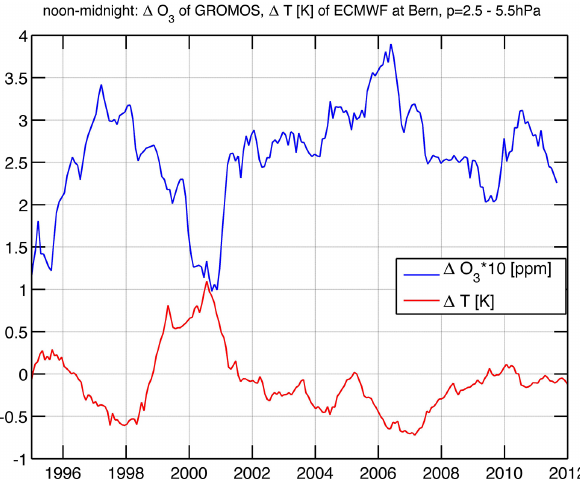
Figure 10. Difference of noon value minus midnight value. The red line shows this difference in case of temperature from ECMWF operational reanalysis (12:00UT minus 00:00UT). The blue line shows the difference in case of ozone from GROMOS at pressure level 4 ± 1 . 5hPa. 1T and 1 O 3 are anticorrelated with R = − 0 .